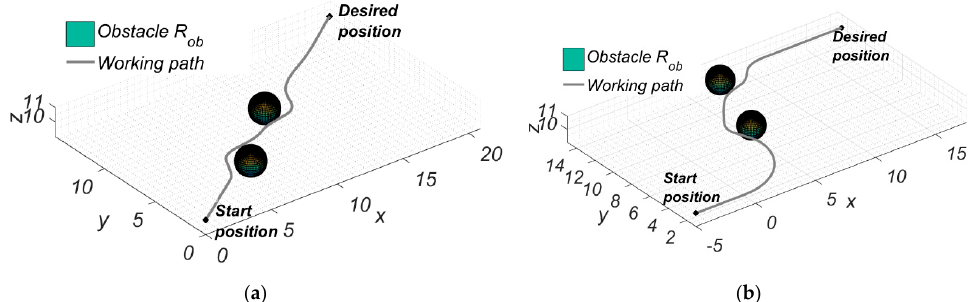
Figure 9. Three-dimension performance of simulations: ( a ) First example with a straight-line trajectory; ( b ) Second example with a spline trajectory.